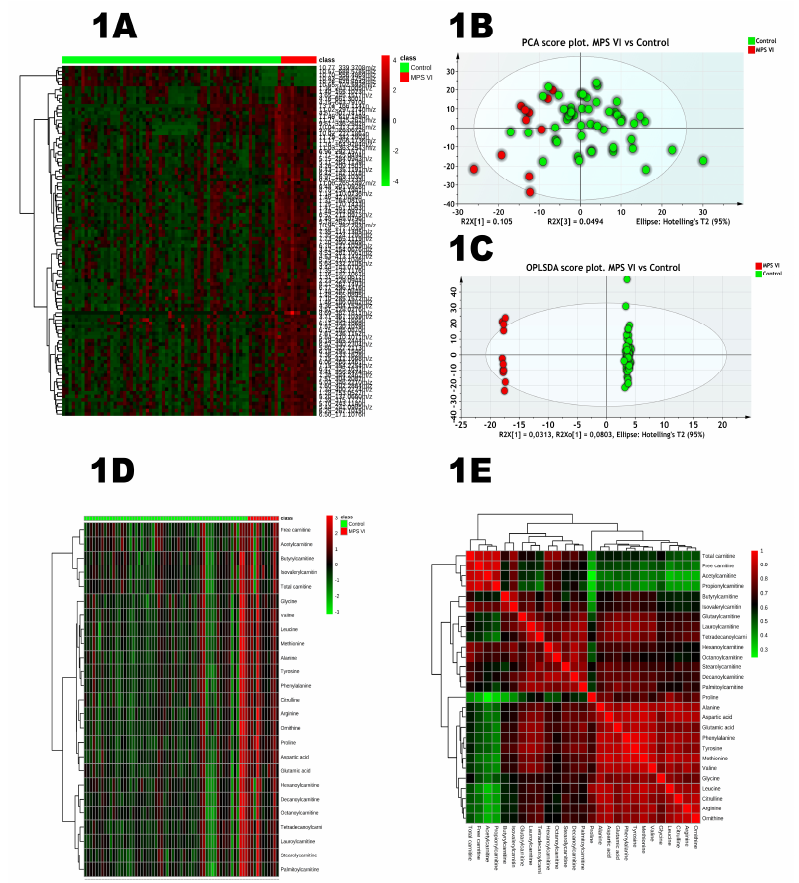
Figure 1. ( A ) Hierarchical cluster analysis and heat map visualization of the top 100 variables ( x -axis) ranked by t -test. The urine sample classes are represented along the x -axis. The color code was used to represent log-scaled intensities of features between − 4 (green) and +4 (red), showing the features’ relative abundance according to the groups. ( B ) PCA scores’ plot of the normalized dataset. The two groups are represented by different colors. A clear separation is observed between the groups with a clear clustering of the control group. ( C ) OPLSDA scores’ plot ( R2 = 0.99, Q2 = 0.60) shows a clear separation between the MPS VI and controls. Detailed model characteristics and validation are given in the Supplementary Materials. ( D ) Heat map representing the clustering of amino acids, free and total carnitine along with acylcarnitines across the two groups: Mucopolysaccharidosis (MPS) VI and controls. Columns represent individual samples and rows refer to amino acid. Shades of red or green represent elevation or decrease, respectively, of an amino acid. ( E ) Spearman rank–order correlation matrix assessed targeted metabolites based on their concentration profiles across all samples. Shades of green or red represent low-to-high correlation coefficient between metabolites.